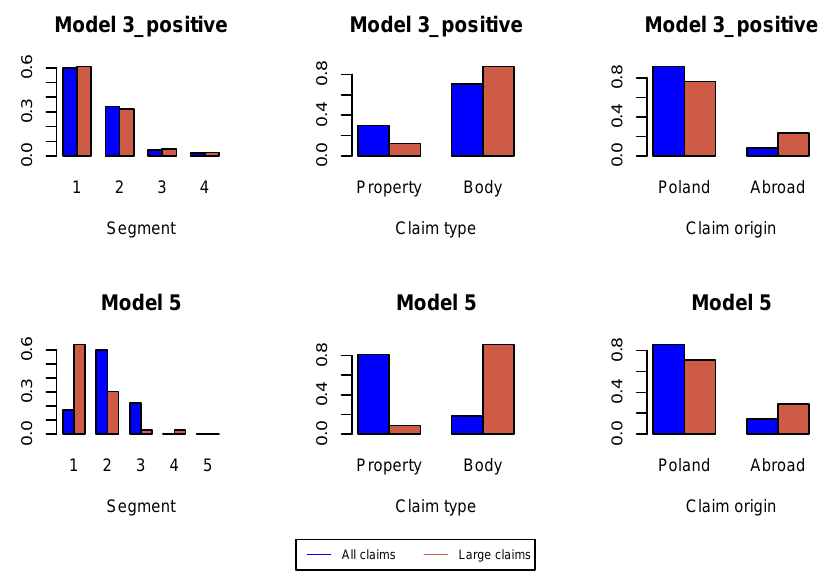
Figure A14. Proportions of claim features in the whole data set and in the data set of large claims in k = 17.